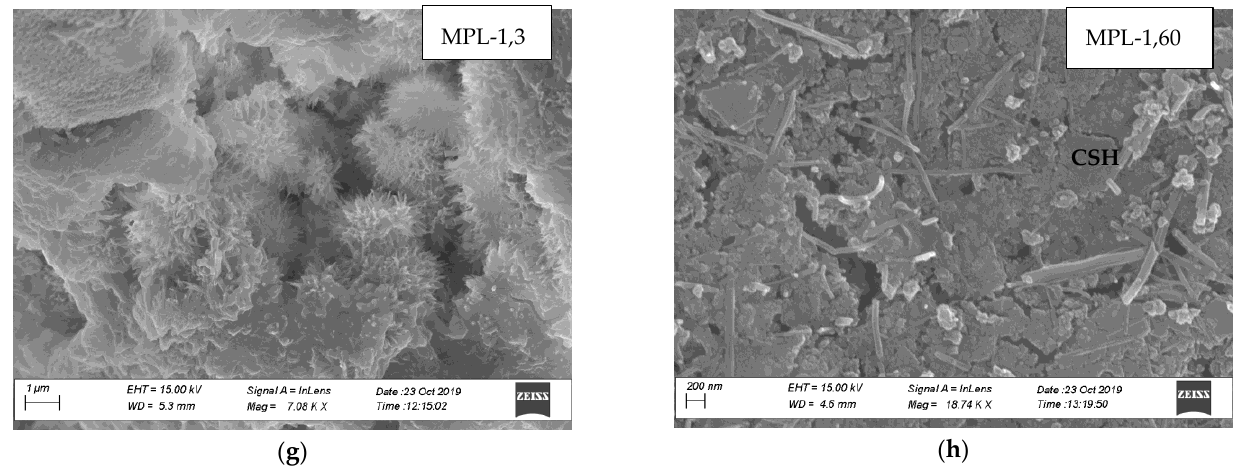
Figure 11. ( a ) Microstructure of OPC at 3 days, ( b ) Microstructure of OPC at 60 days, ( c ) Microstructure of OPC replaced with 1% nano CaCO 3 at 3 days, ( d ) Microstructure of OPC replaced with 1% nano CaCO 3 at 60 days, ( e ) Microstructure of PLC at 3 days, ( f ) Microstructure of PLC at 60 days, ( g ) Microstructure of PLC replaced with 1% nano CaCO 3 at 3 days, ( h ) Microstructure of PLC replaced with 1% nano CaCO 3 at 60 days.